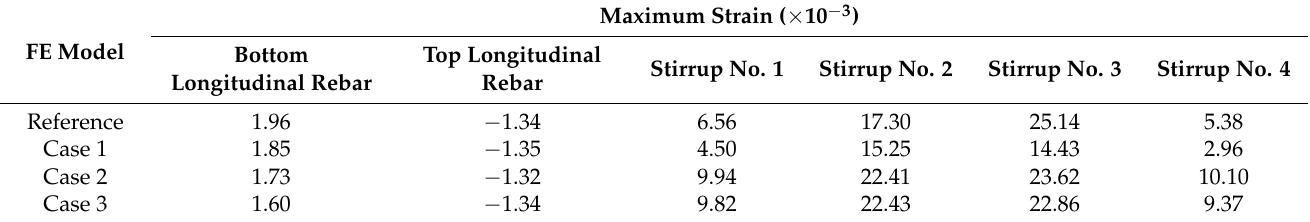
Table 10. Maximum reinforcement strain at peak load for different levels of ASR degradation (refer to Figure 4 for numbering of stirrup strain